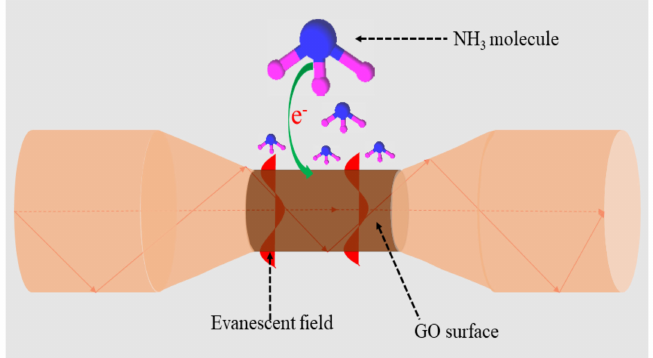
Figure 9. NH 3 gas sensing mechanism of GO-coated optical microfiber